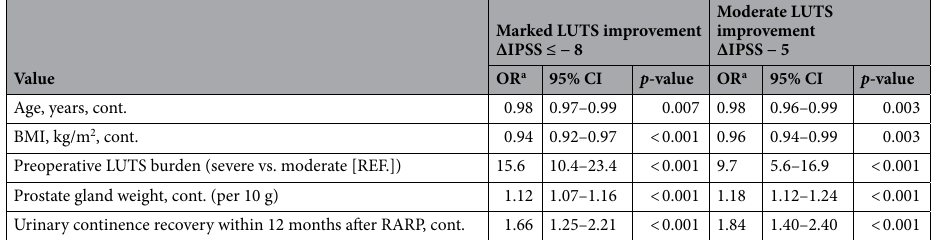
Table 2. Multivariable logistic regression model for prediction of marked and moderate LUTS improvement after robot-assisted radical prostatectomy in patients with moderate or severe preoperative LUTS. CAPRA-S: the postsurgical Cancer of the Prostate Risk Assessment score; IPSS: International Prostate Symptom Score; LUTS: lower urinary tract symptoms; RARP: robot-assisted radical prostatectomy. a Adjusted for surgical experience, preoperative PSA, preoperative medication with alpha-blockers, 5-alpha-reductase inhibitors, neoadjuvant androgen deprivation, CAPRA-S score, nerve-sparing status and bladder neck reconstruction